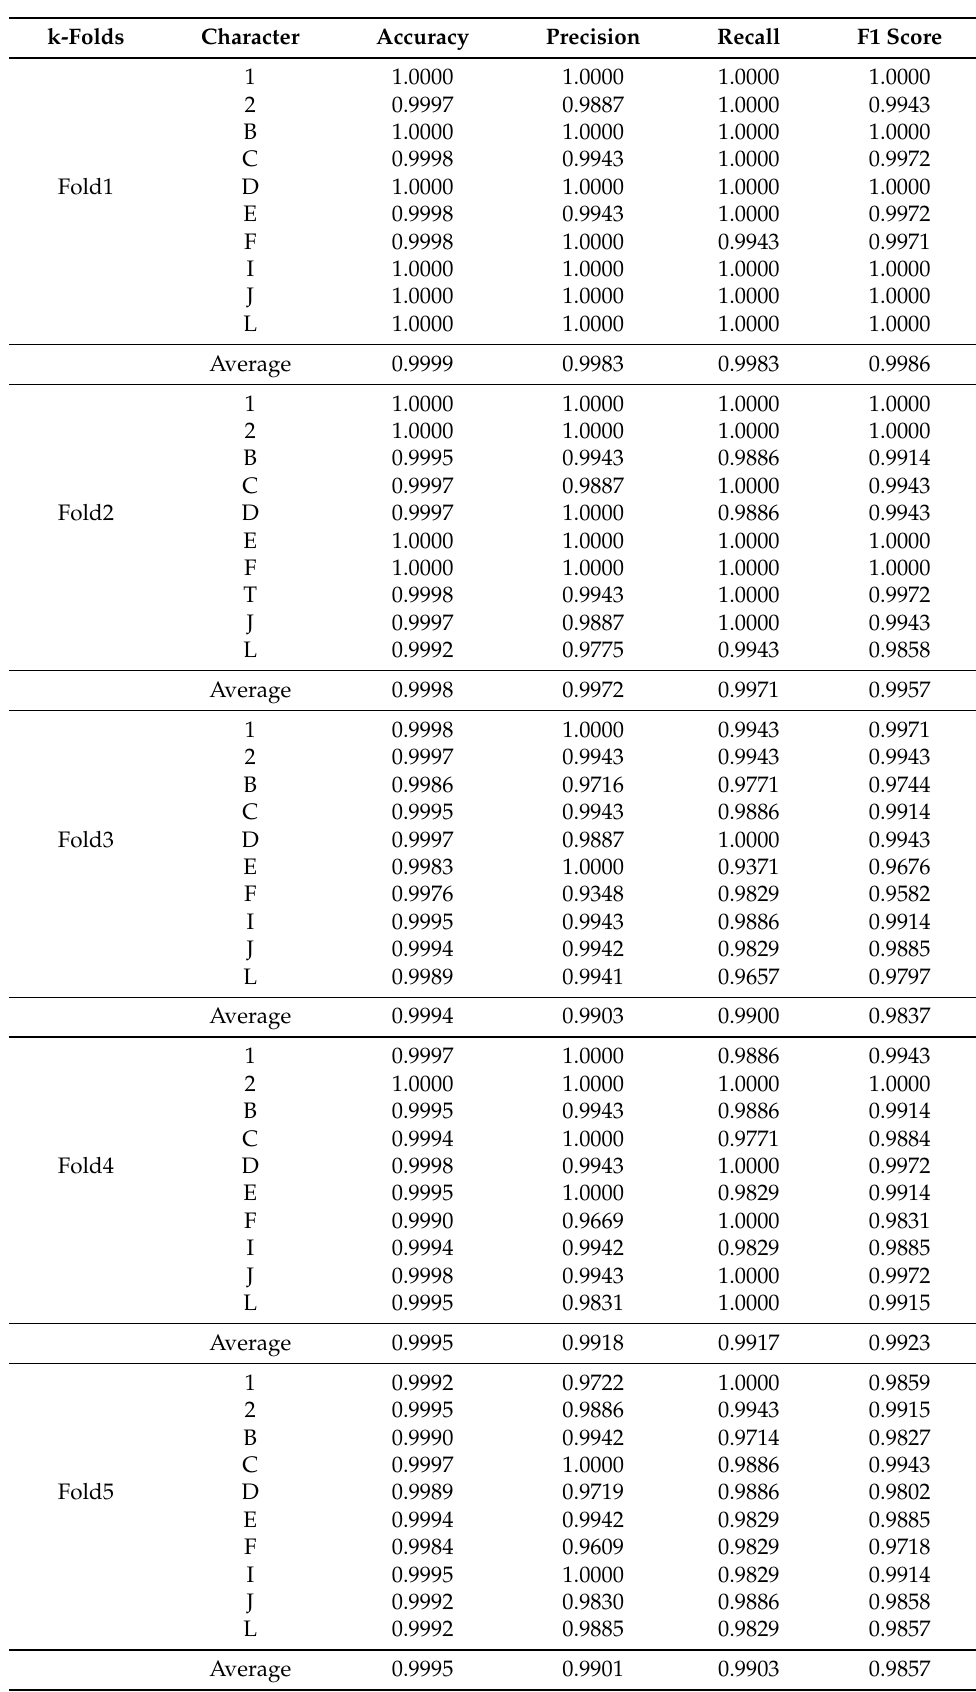
Table 4. Five-fold cross validation of the EfficientNet-B0 networks from selected